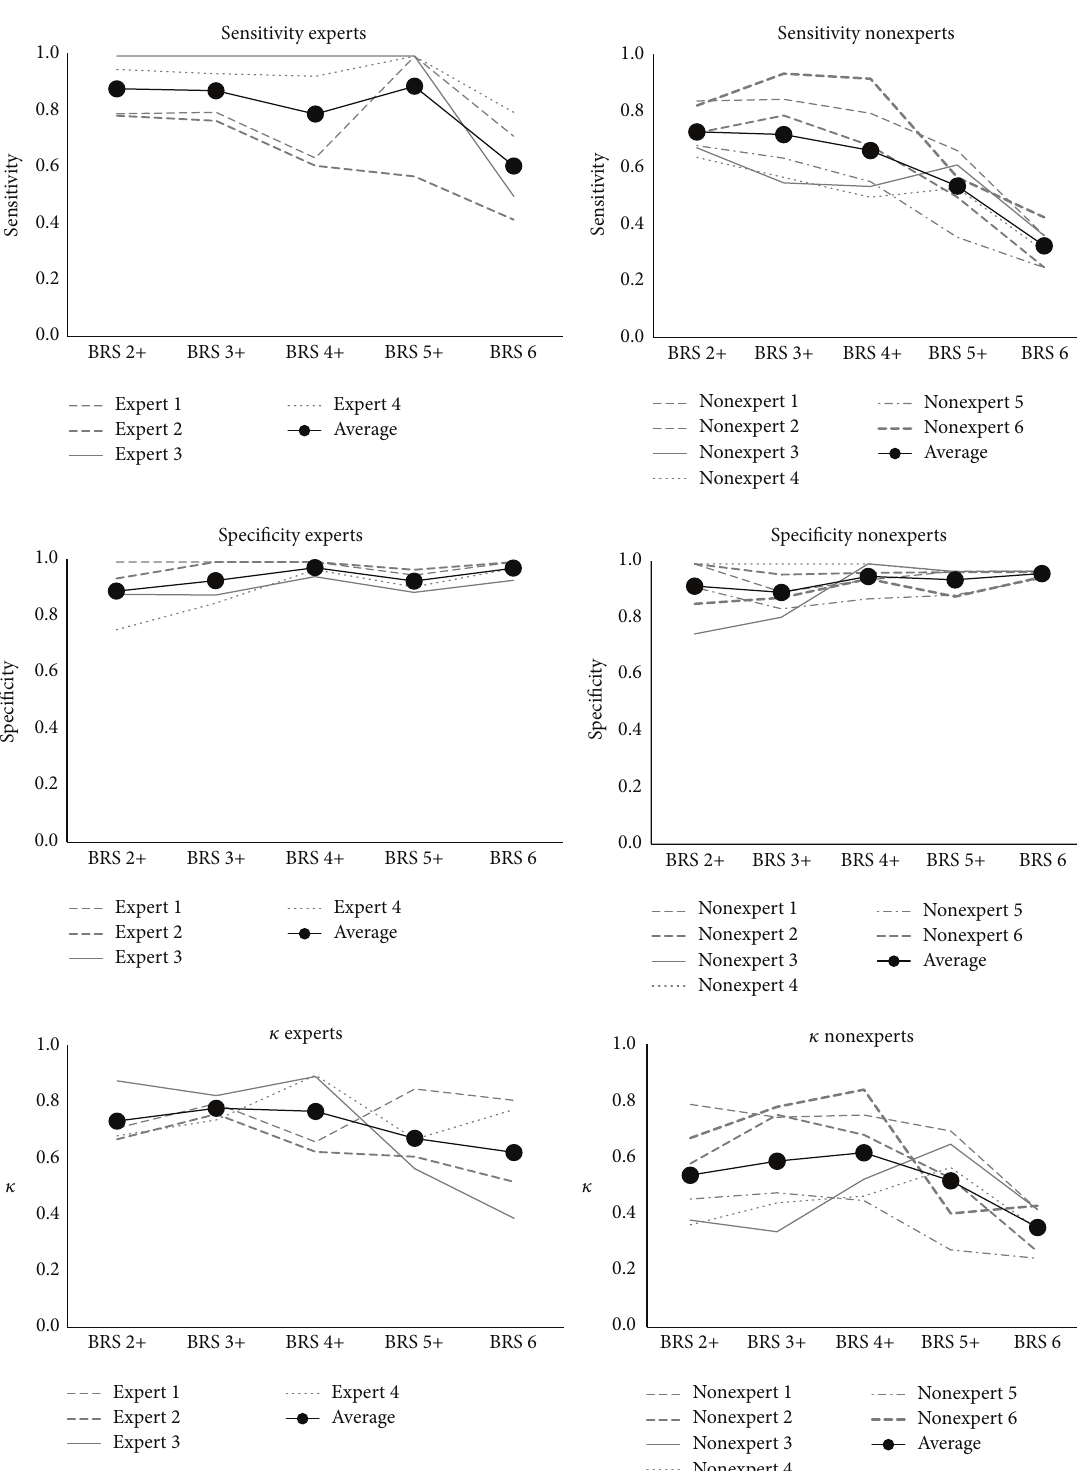
Figure 2: Specificity, sensitivity, and agreement ( 𝜅 ) of nonexperts and experts with the expert consensus score in relation to different bolus residue scale